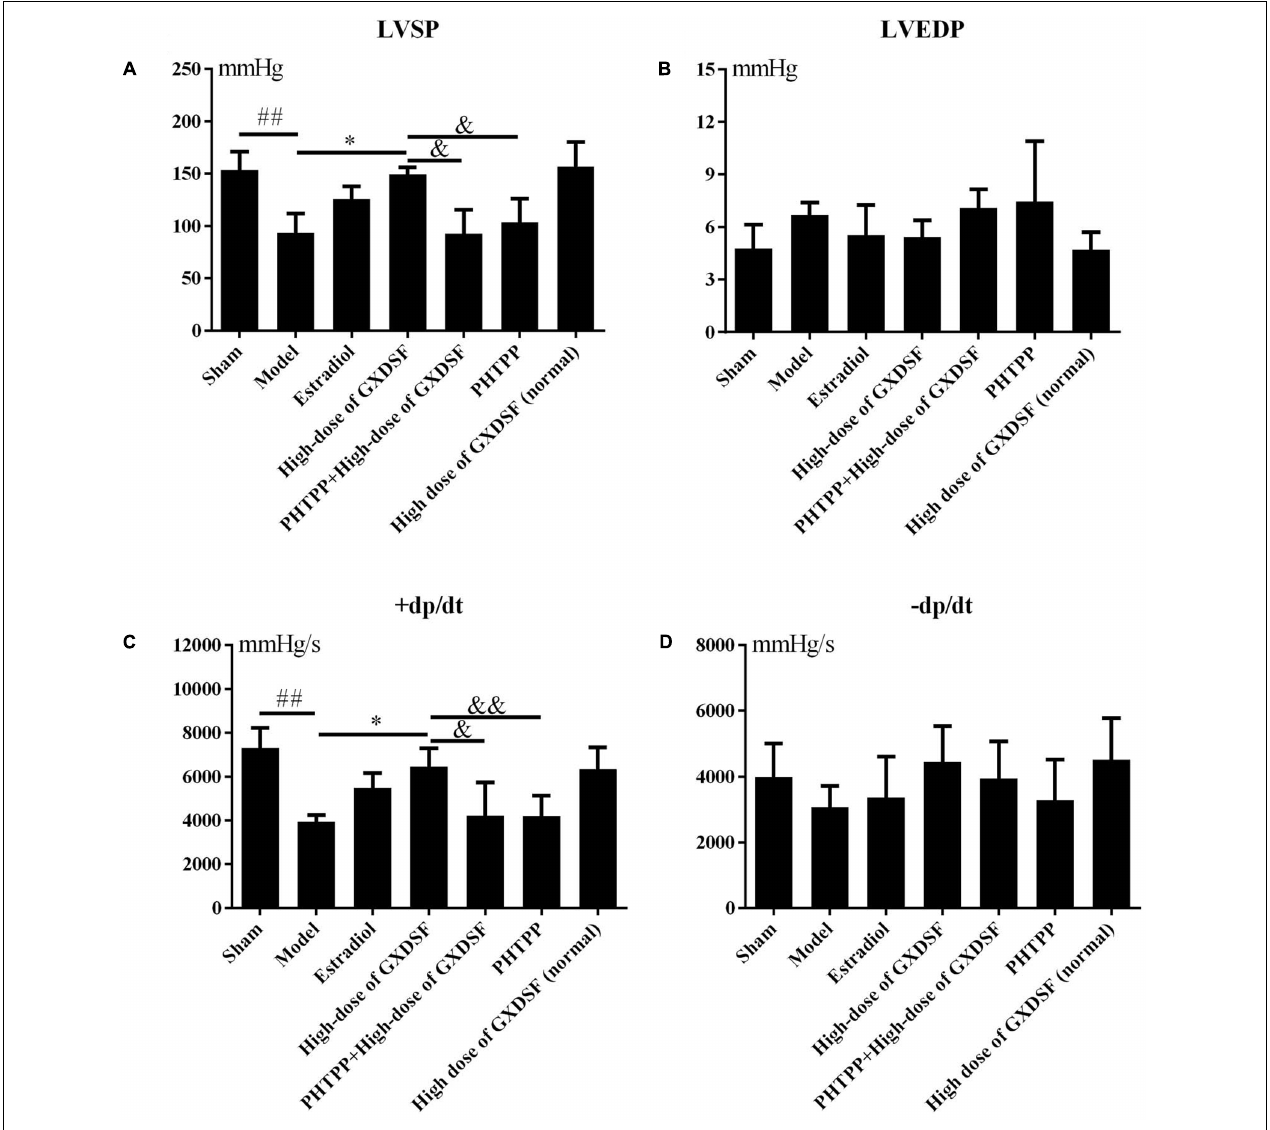
FIGURE 2 | Haemodynamic parameters, including LVSP (A) , LVEDP (B) , +dp/dt (C) , and –dp/dt (D) , in MIRI-LVR rats treated with high-dose of GXDSF treated group and PHTPP. Compared with the sham group: ## P < 0.01. Compared with the MIRI-LVR model group: ∗ P < 0.05. Compared with the high-dose of